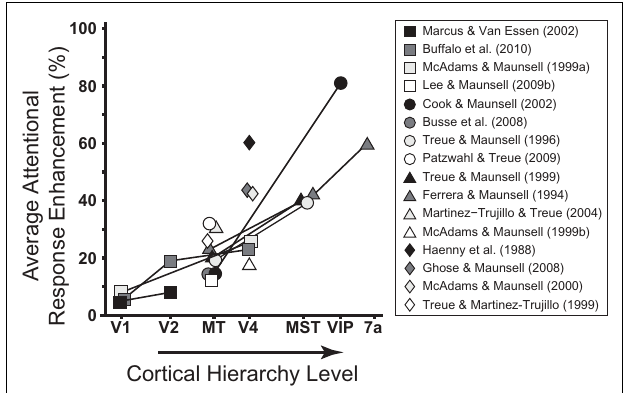
FIGURE 1 |The strength of attentional modulation increases with level of cortical hierarchy (extended version of Figure 12 in Cook and Maunsell, 2002). The different symbols represent the different studies used in the meta analysis. Lines between two symbols indicate that these data are from the same study.